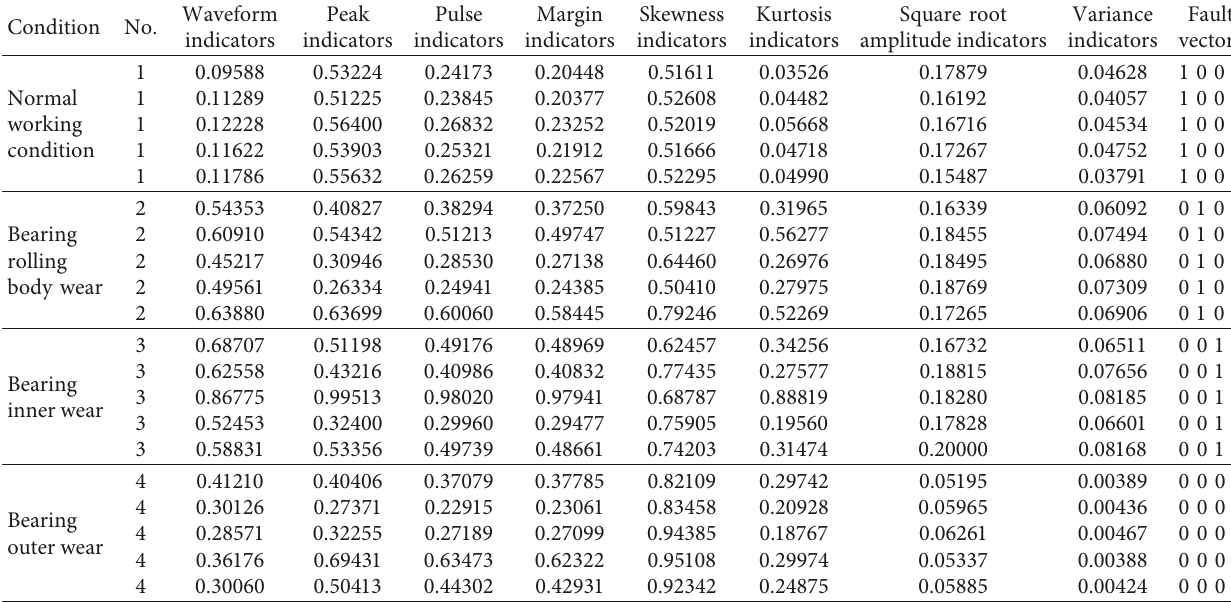
Table 3: Gearbox rolling bearing part of the test data.